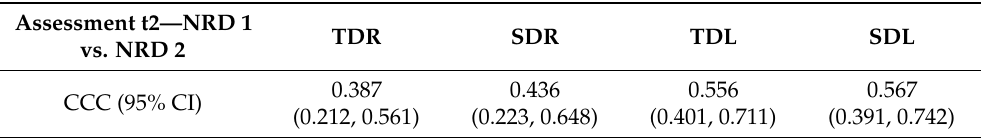
Table 5. Inter-rater agreement in ONSD MRI assessment between the two neuroradiologists in the second assessment (assessment t2, NRD 1 vs. NRD 2). Inter-rater agreement comparing the second MRI assessment of the two neuroradiologists.